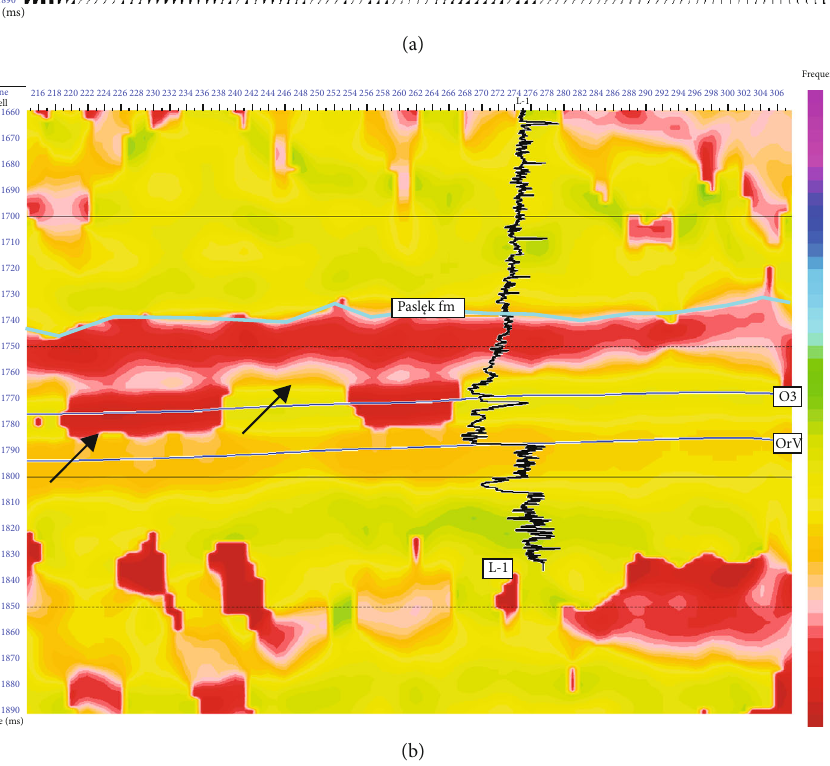
Figure 12: Zoomed seismic pro fi le that goes through the well: (a) migrated seismic section, (b) spectral decomposition based on the CWT algorithm. The curve is P wave velocity. In (b), red colours indicate lower frequencies, and purple indicates higher frequencies. Horizons ’ marks are O3: the top of the Prabuty formation and Orv: top of the Kopalino formation. Arrows indicate the characteristics of the low frequency anomaly (described in